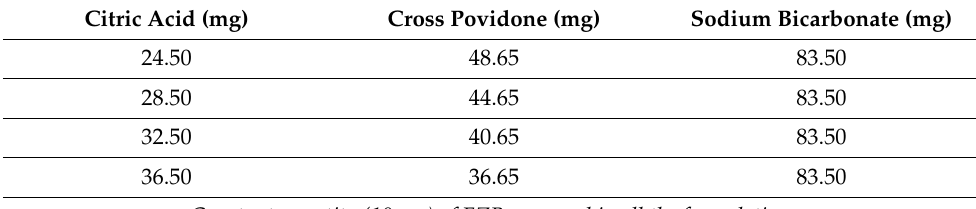
Table 1. Composition of immediate-release layer.